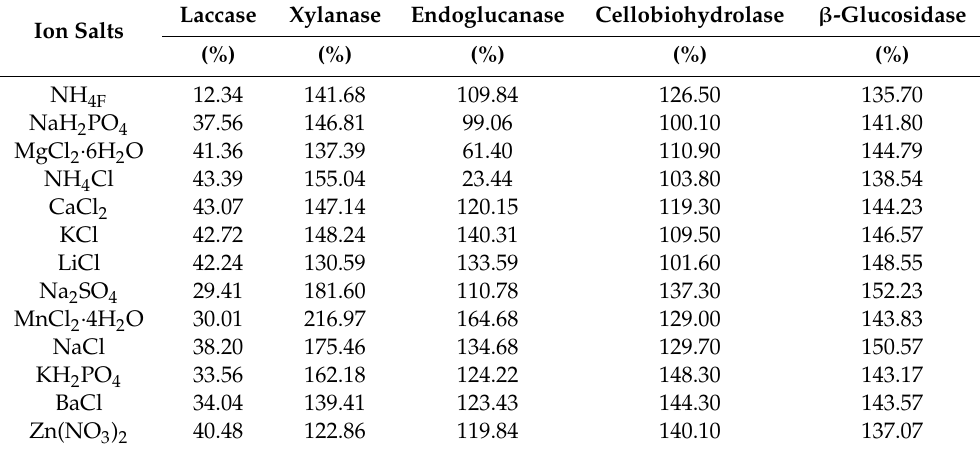
Table 3. E ff ects of ion salt in solution on the enzyme